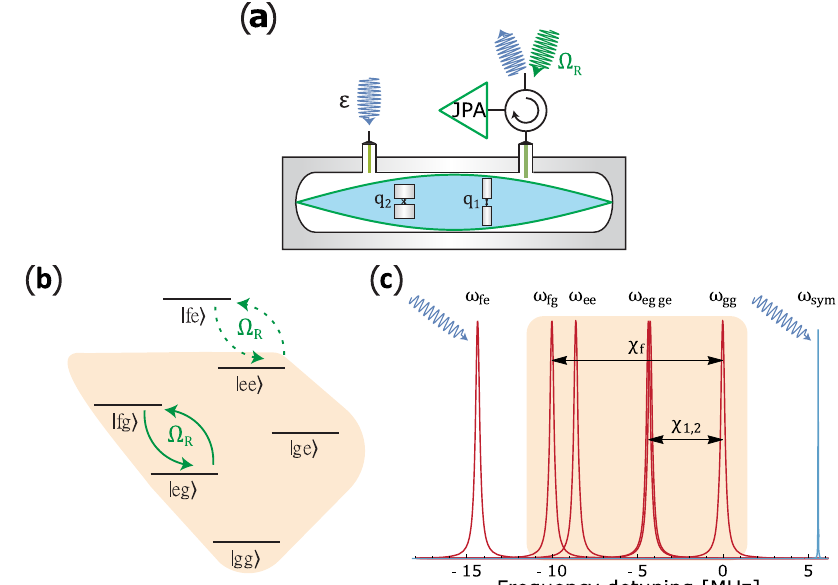
Fig. 1 Experiment schematic. a Two transmons coupled to electromagnetic-mode of a superconducting cavity. b Qutrit-qubit energy level diagram, where the energy levels of each element are labeled g (ground), e (excited), and f (second excited level). The colored domain is the subspace de fi ned by the projector P ¼ 1 (cid:2) fe j i fe h j . The e j i $ f j i transition of the qutrit q1 is Rabi driven with frequency Ω R . Dotted and solid lines are blocked and allowed transitions, respectively. c Cavity spectra conditioned on transmon state (red) and the applied Zeno measurement drive and symmetric drive